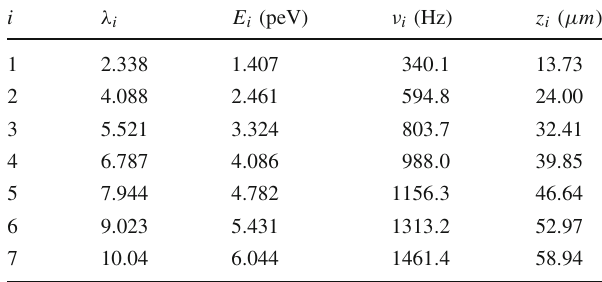
Table 2 Eigenvalues λ i (roots of Airy function), gravitational energies E i , characteristic transition frequencies ν i and classical turning points